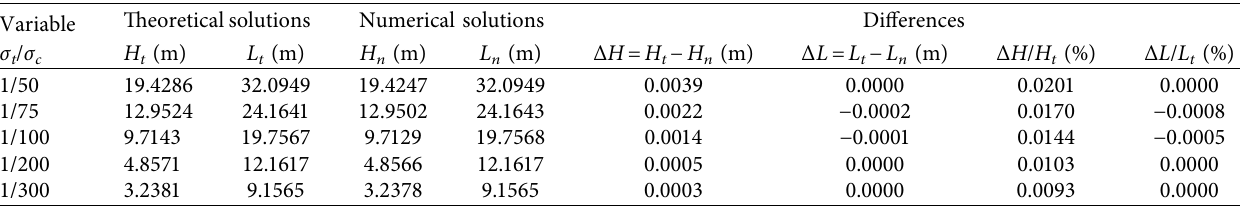
Table 3: Comparison of height H and width L of collapse block between theoretical solutions and numerical solutions with varied parameter σ t / σ c .